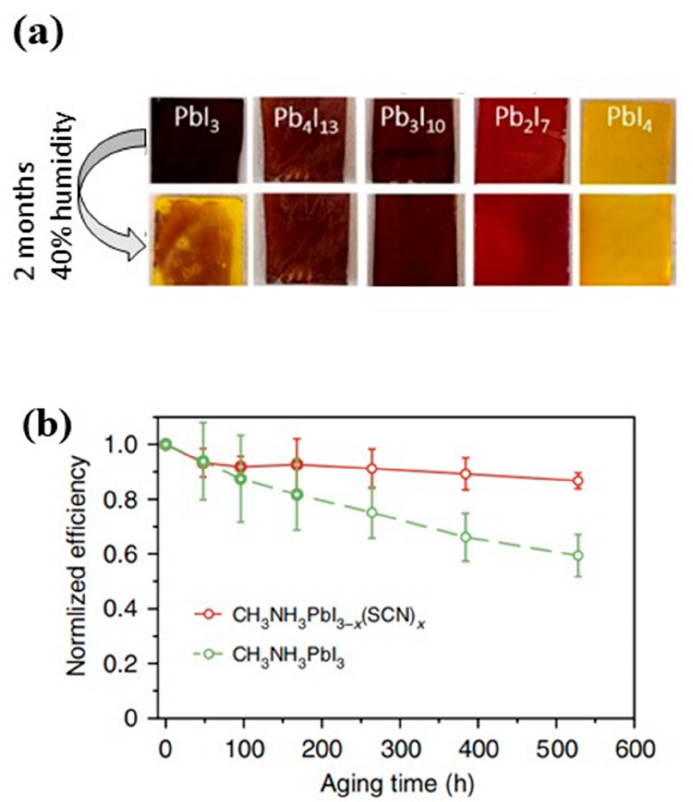
Figure 5. ( a ) Images of different (CH 3 (CH 2 ) 3 NH 3 ) 2 (CH 3 NH 3 ) n-1 Pb n I 3n+1 perovskite films before and after exposure to 40% humidity (Reprinted with permission from Ref. [159]. Copyright: American Chemical Society 2015); and ( b ) the evolution of the PCEs of CH 3 NH 3 PbI 3 and CH 3 NH 3 PbI 3 − x (SCN) x -based solar cells after gaining in air without encapsulation (Reprinted with permission from Ref. [58]. Copyright: Springer nature